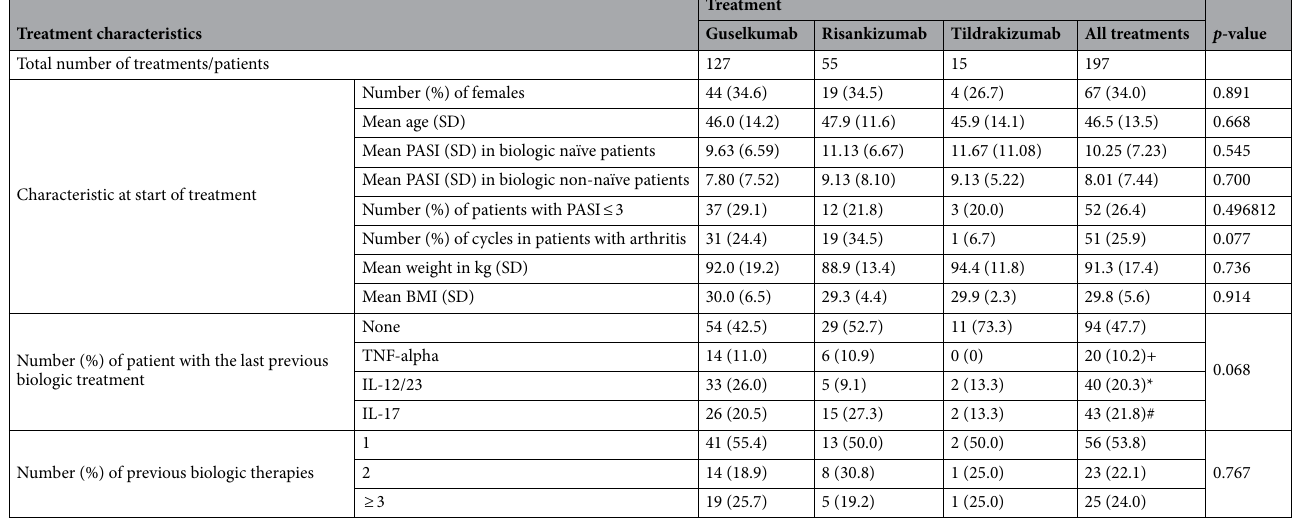
Table 1. Patient characteristics. Analysis of variances and chi-square test did not reveal differences in allocation to treatment regarding sex, age, PASI, psoriatic arthritis, or (type of) previous biologic exposure. Chi-square test results revealed that a previous treatment with TNF-alpha and IL-12/23 inhibitors were the first biologic treatments for a significantly higher proportion of patients ( p = 0.000778). +Seven patients (35.0%) were biologic-non-naïve when treated with TNF-alpha inhibitors. *Ten patients (25.0%) were biologic- non-naïve when treated with IL-12/23 inhibitors. #Twenty-eight patients (65.1%) were biologic-non-naïve when treated with IL-17 inhibitors. BMI, body mass index; IL, interleukin; PASI, Psoriasis Area and Severity Index; SD, standard deviation; TNF, tumour necrosis